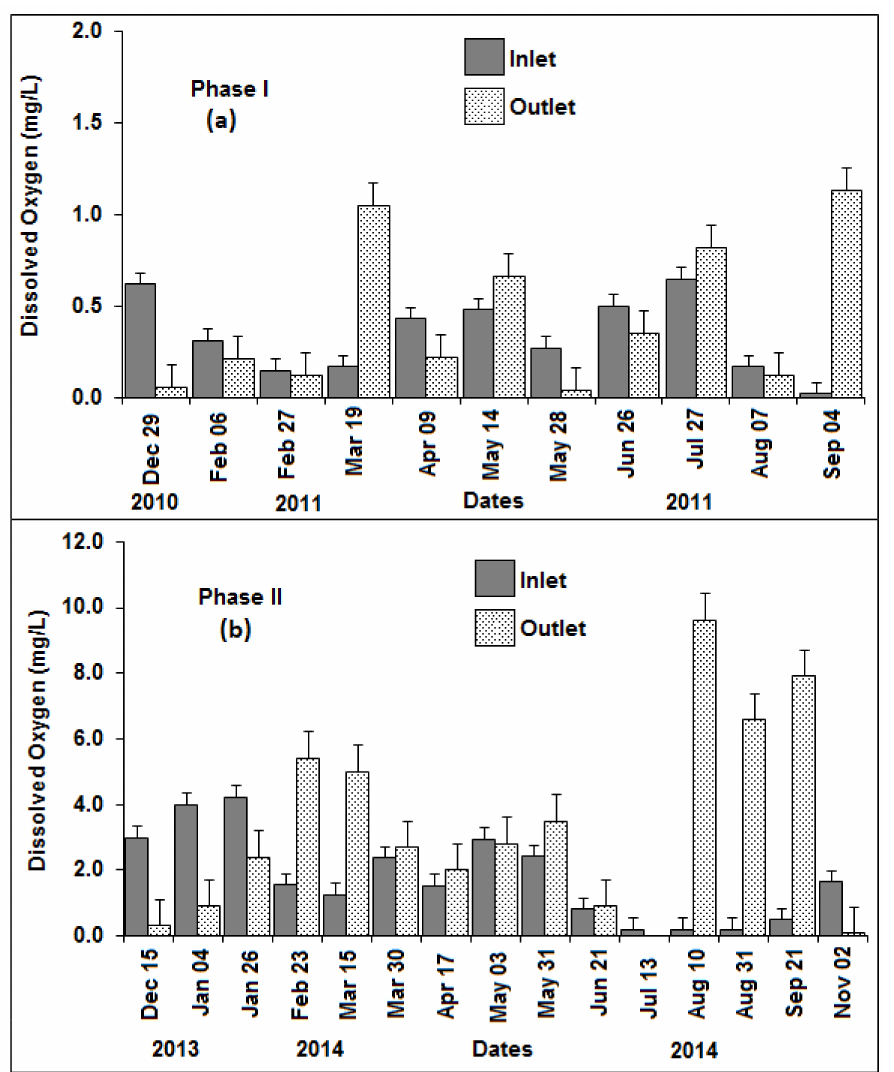
Figure 5. Dissolved oxygen (DO) from combined inlet and the lagoon’s outlet for the period of: ( a ) 29 December 2010 to 4 September 2011 (Phase One) and ( b ) 15 December 2013 to 2 November 2014 (Phase